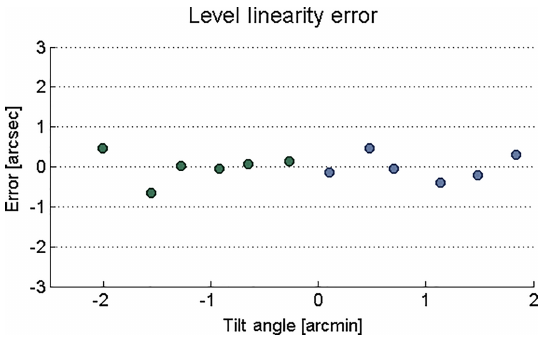
Figure 1. AutoDIF tilt sensor linearity error. The tilt range is ± 2 (cid:48) .